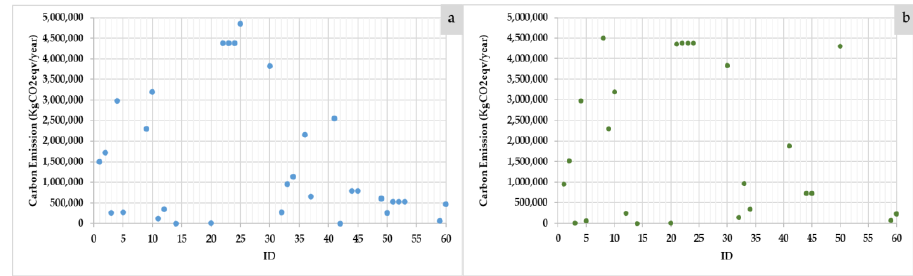
such as SDG-1 No poverty, SDG-2 Zero Hunger, SDG-6 Clean Water and Sanitation, SDG- 7 Affordable and Clean Energy and SDG-13 Climate Action. Developing water pressur- ized systems in these areas often need implementation assistance from international and national programs [91,92]. One of the main indicators used for decision-making is the monetary factor, which, as shown in Figure 8, when making changes in the operation and element that has a pres- surized supply network, the annual energy cost related to water use is maintained at val- ues below 1,500,000 €/year except for a peak value that reaches a cost of almost 40 M€/year. If the initial operating systems are maintained, the costs exceed 70 M€/year, and there is a peak value of almost 300 M€/year. Particularly, [15] reductions in operational costs de- creased from EUR 0.035 to 0.029/m 3 , an improvement of 15.54%. However, the energy cost